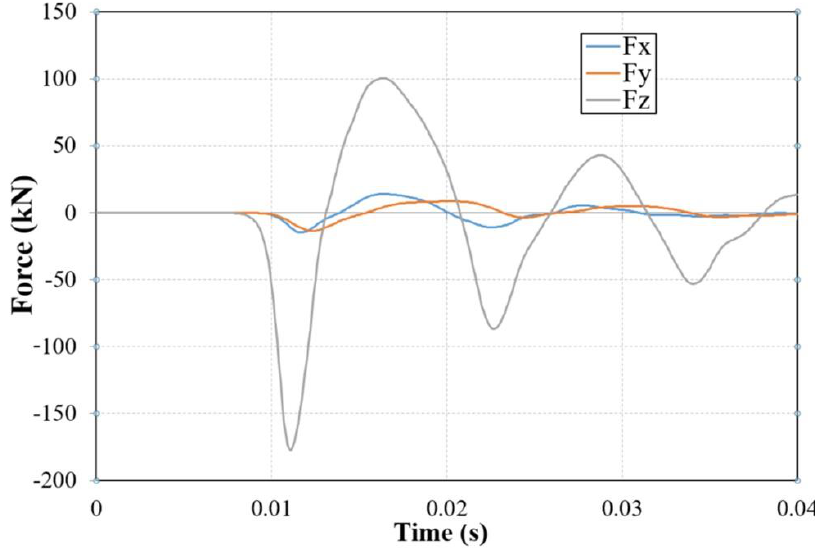
Figure 5. Components of forces acting on an obstacle at a distance of 5 m depending on time.